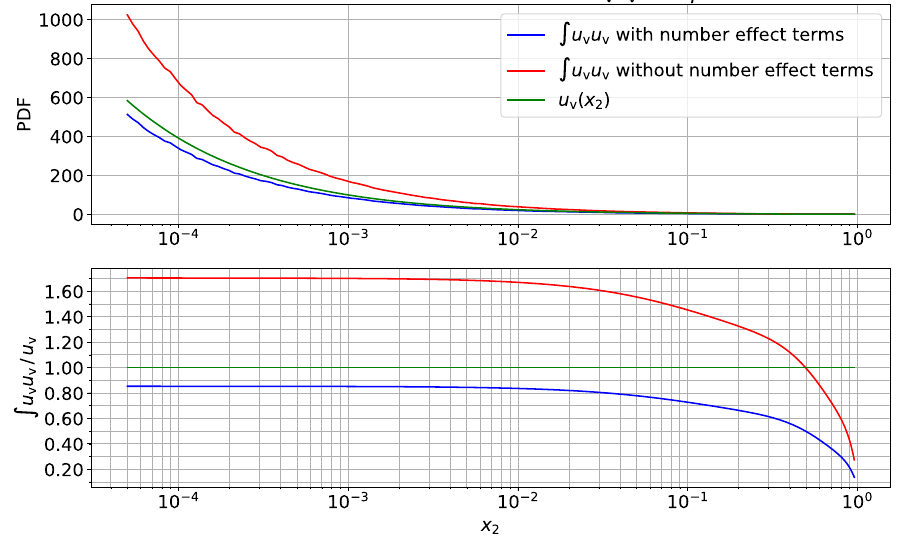
Figure 16 . Veri(cid:12)cation of the number sum rule for u v u v for the two types of initial conditions. The blue and red curves give the evolution of the distribution de(cid:12)ned in eq. (B.3) as a function of x 2 for (cid:22) = (cid:23) = 80 GeV. The green curve gives the distribution u v ( x 2 ; (cid:22) 2 ). According to the number sum rule, the ratio should be equal to